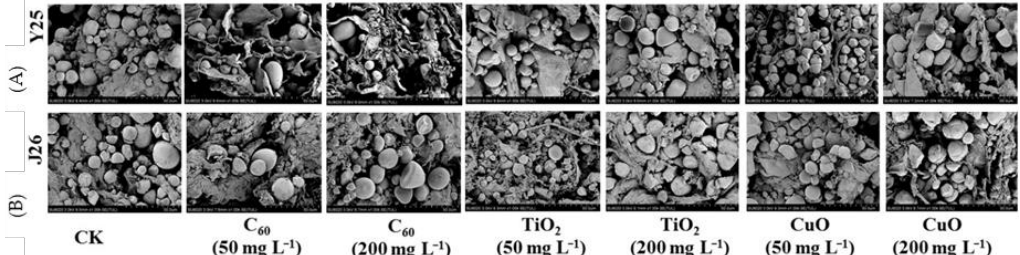
Figure 4. Representative scanning electron microscopic (SEM) images of the cross sections of inoculated sweet potato ( A )